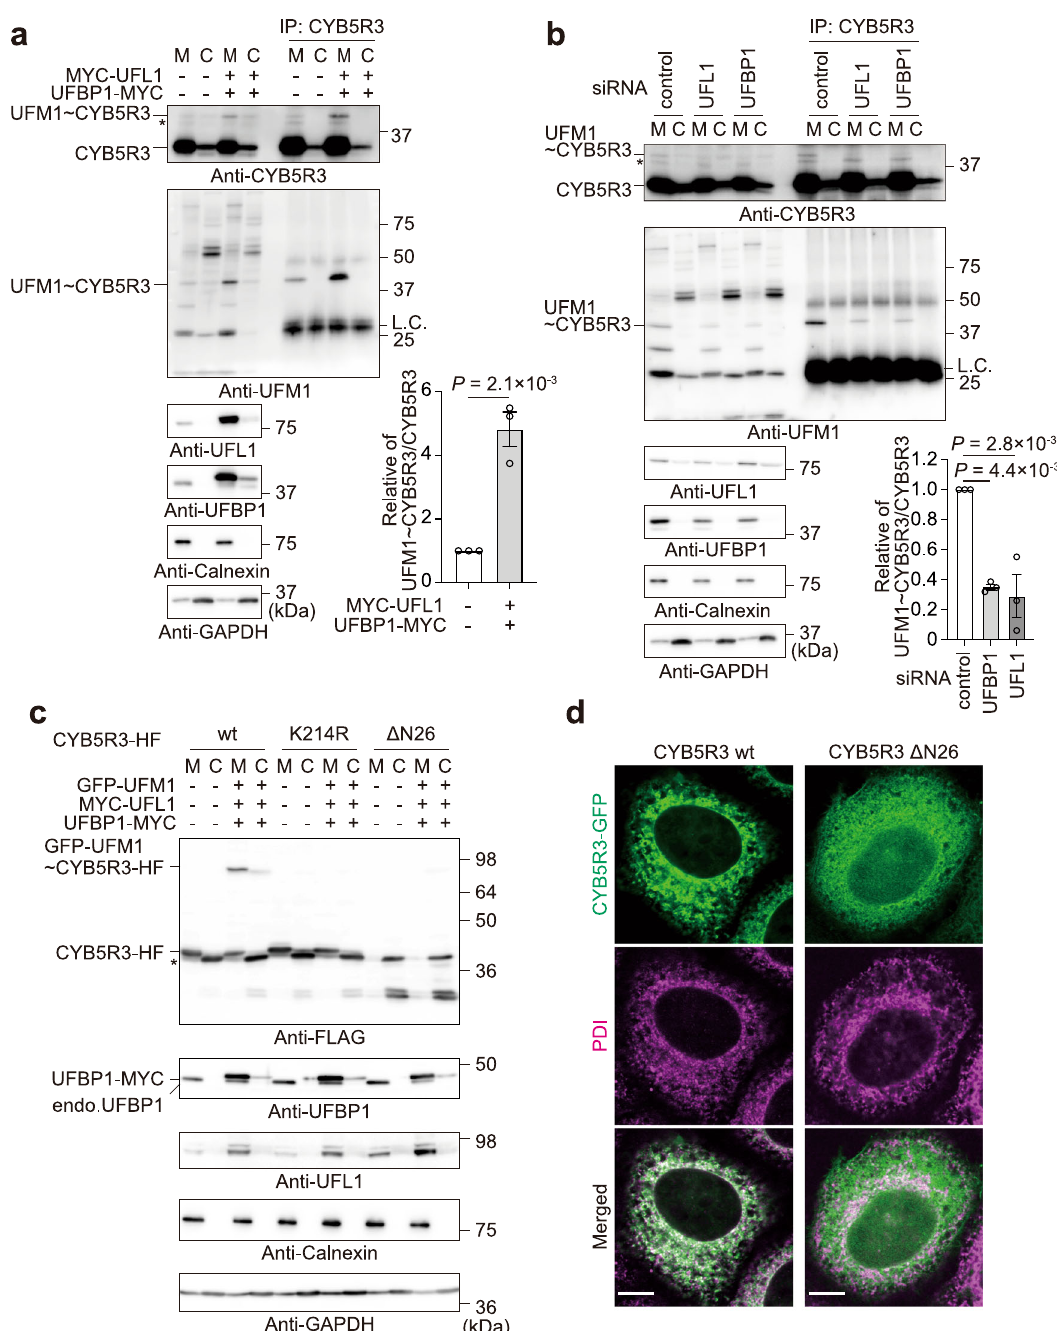
Fig. 2 | Ufmylation of CYB5R3 on the ER. a Immunoprecipitation assay. HEK293TexpressingUFL1andUFBP1werefractionatedintomicrosomal(M)and cytoplasmic(C)fractions.ThefractionsweredenaturedwithTNEwithSDS( fi nal 1%), diluted 10-fold withTNE,and thenimmunoprecipitated withCYB5R3anti- bodyfollowedbyimmunoblotanalyses.Datashownarerepresentativeofthree separateexperiments. Bargraphs show therelative valueof the ratio of endo- genous ufmylated CYB5R3to CYB5R3was 1whenneitheroverexpressionnor knockdown of anyE3components wasperformed.Dataare means± s.e.Statis- ticalanalysiswasperformedbytwo-sidedWelch ’ s t test. b Immunoprecipitation assay. UFL1 or UFBP1 in UFSP2 − / − HEK293Twereknockeddown,andthecellswere fractionated into microsomal(M)and cytoplasmic(C) fractions. Thefractions wereanalyzedasdescribedin a .Datashownarerepresentativeoffourseparate experiments.Bar graphs showthe relative value of the ratio of endogenous ufmylated CYB5R3to CYB5R3was 1when neitheroverexpressionnor